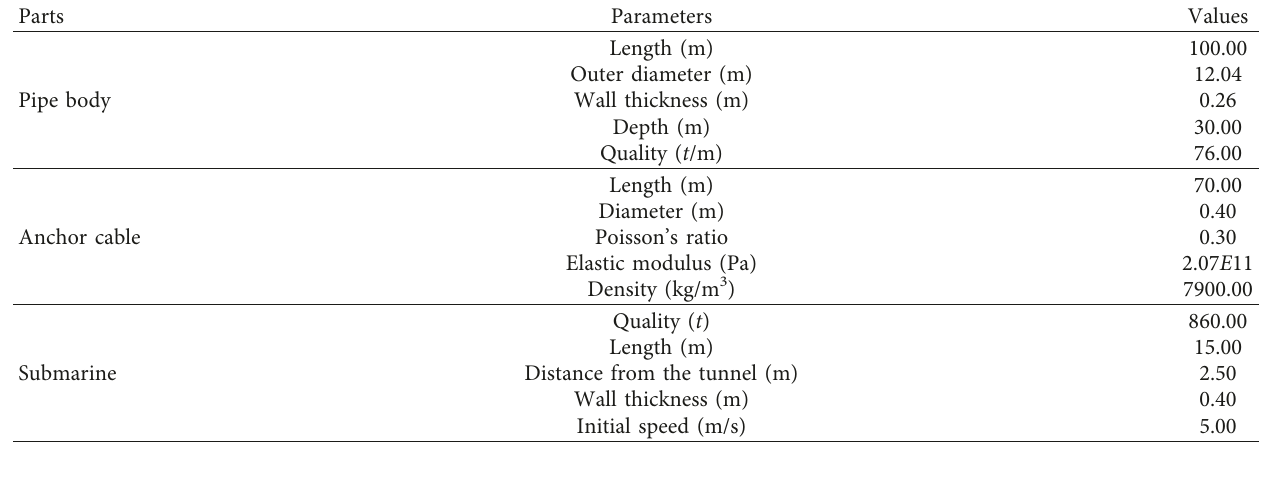
Table 1: Parameters of the models.